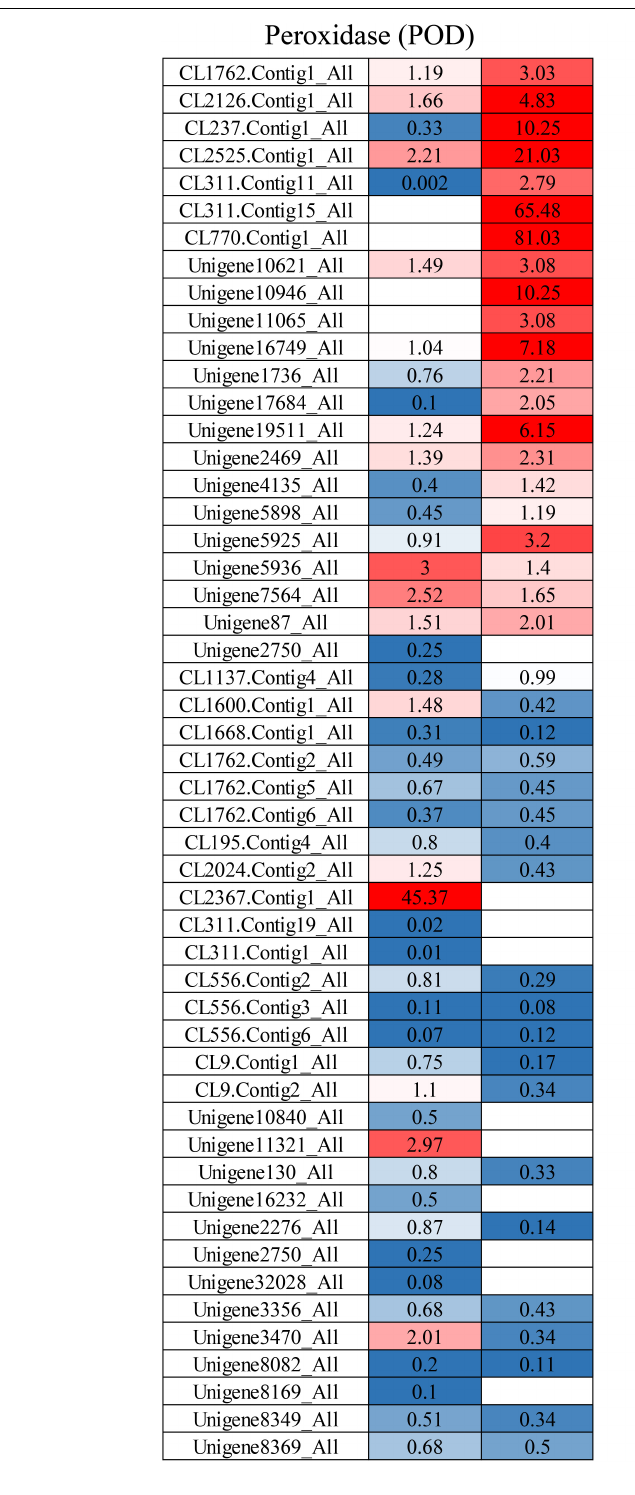
FIGURE 4 | The clustering chart of Arg-induced DEGs related to antioxidant systems in G. lemaneiformis under high temperature. The same row represents the abundance change of one unigene at 24 h (left column) and 48 h (right column), the number in each square beside the enzyme code refers to the fold change of corresponding DEGs. Red and blue squares indicate upregulation and downregulation, separately, while white means are not expressed at this time point. DEGs, differentially expressed genes; Arg, L-Arginine.